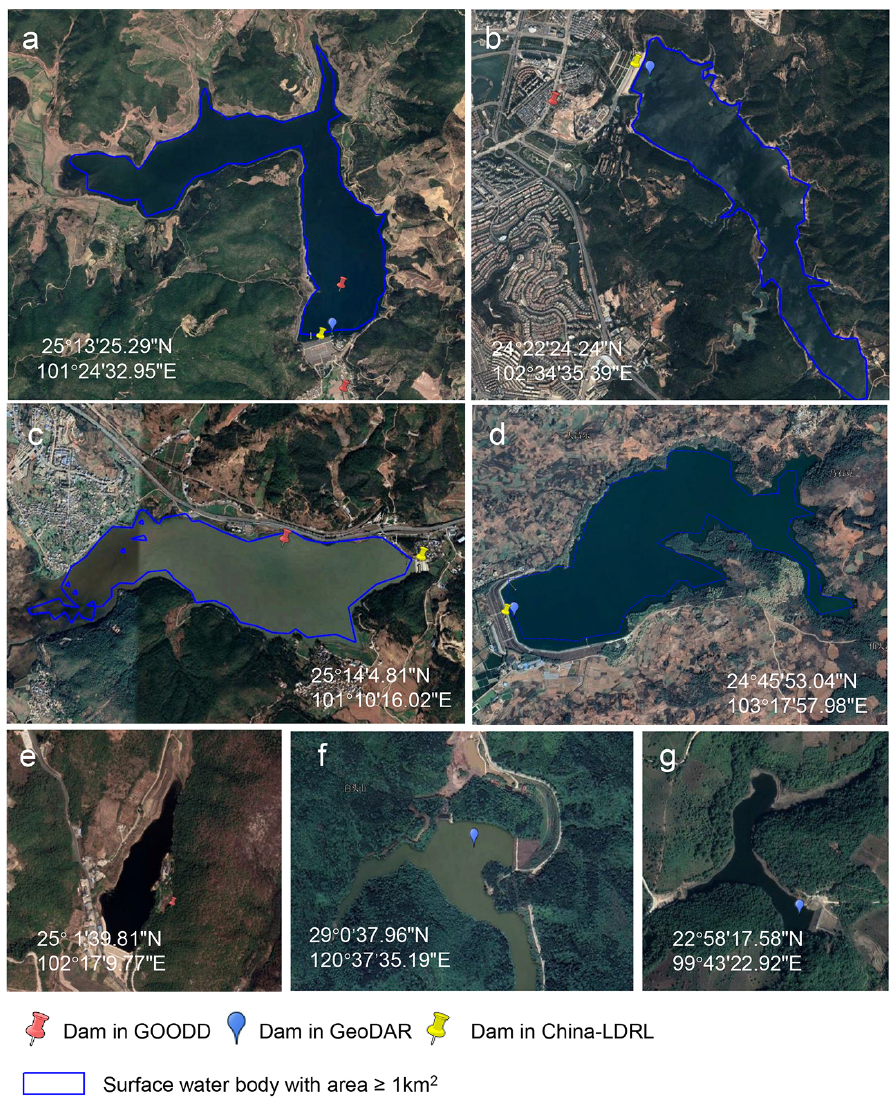
Figure 10. Dams from the GOODD, GeoDAR, and China-LDRL datasets within Google Earth Pro (© Google Earth Pro 2019).